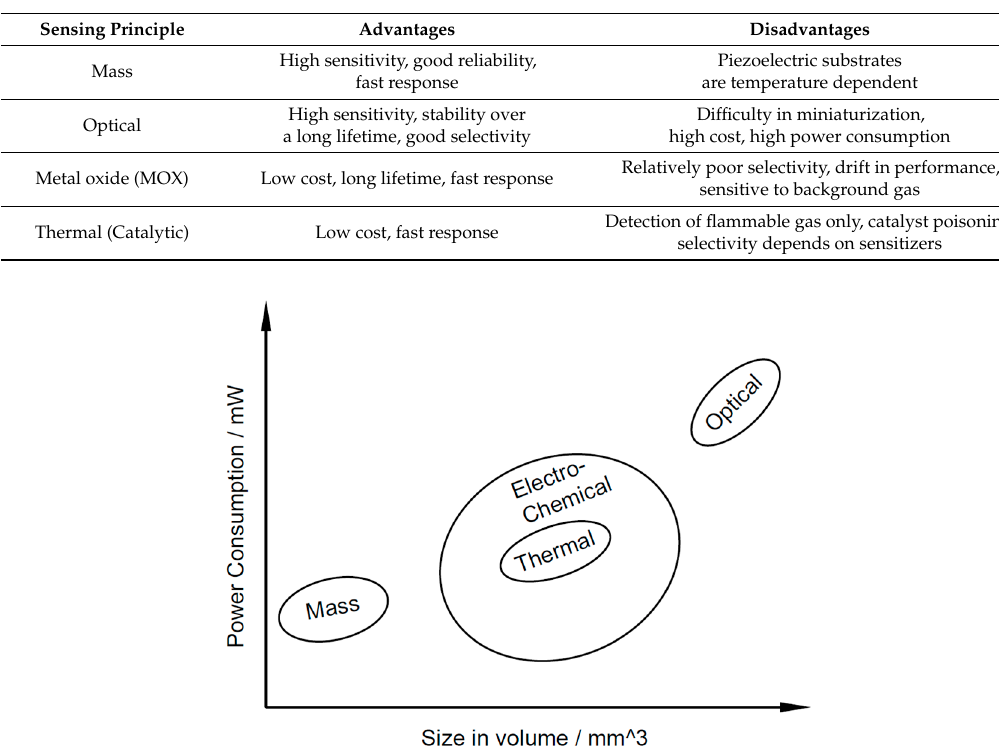
Table 1. Comparison of the four types of gas sensors.